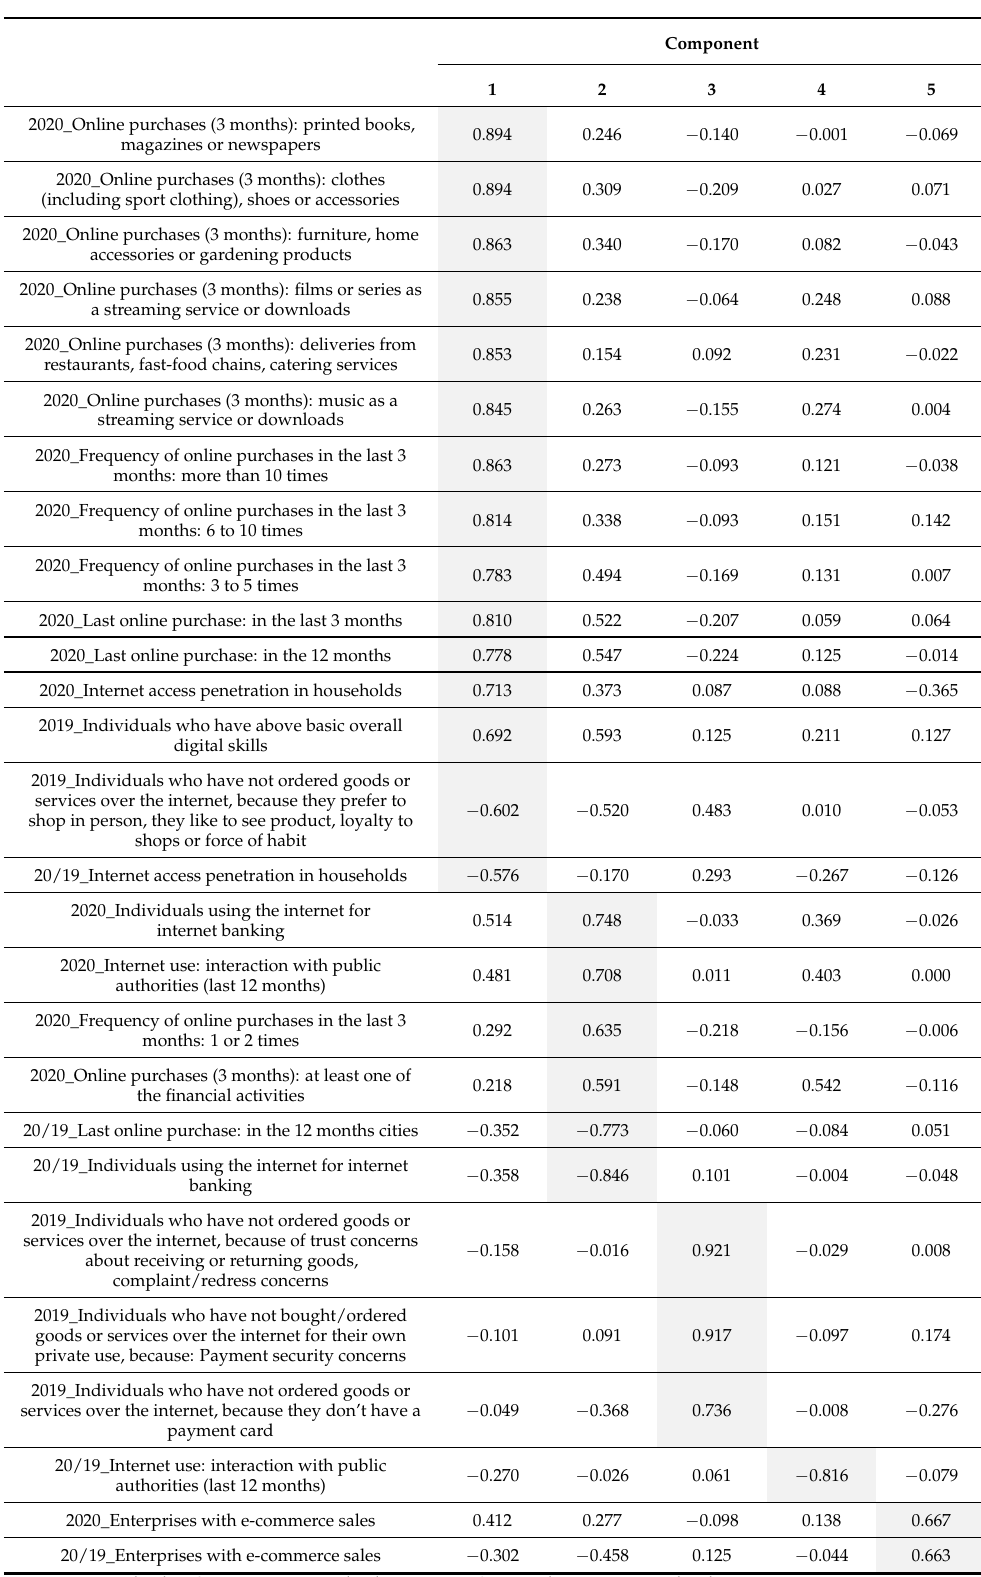
Table 1. Rotated component matrix